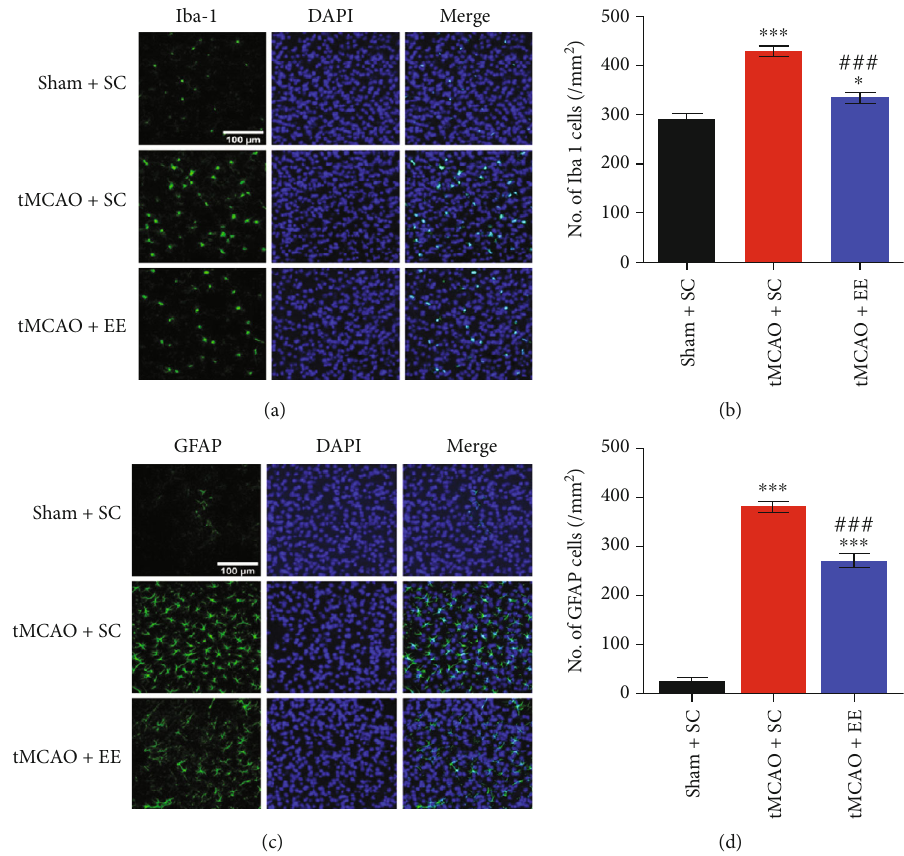
Figure 4: (a) Staining results for microglia. (b) Comparison of the number of microglia between groups. (c) Staining results for astrocytes. (d) Comparison of the number of astrocytes between groups (b, d) ∗ P < 0 : 05 and ∗∗∗ P < 0 : 001 vs . sham+SC group; ## P < 0 : 01 and ### P < 0 : 001 vs . tMCAO+SC